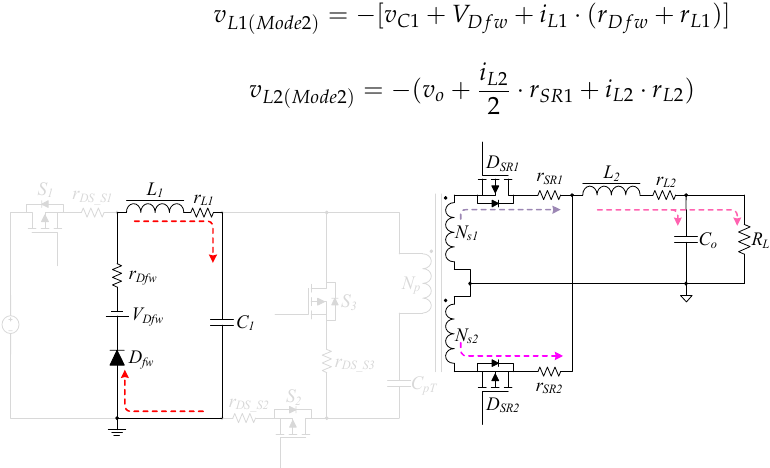
Figure 16. Equivalent circuit operating during [ DT , 0.5 T ].